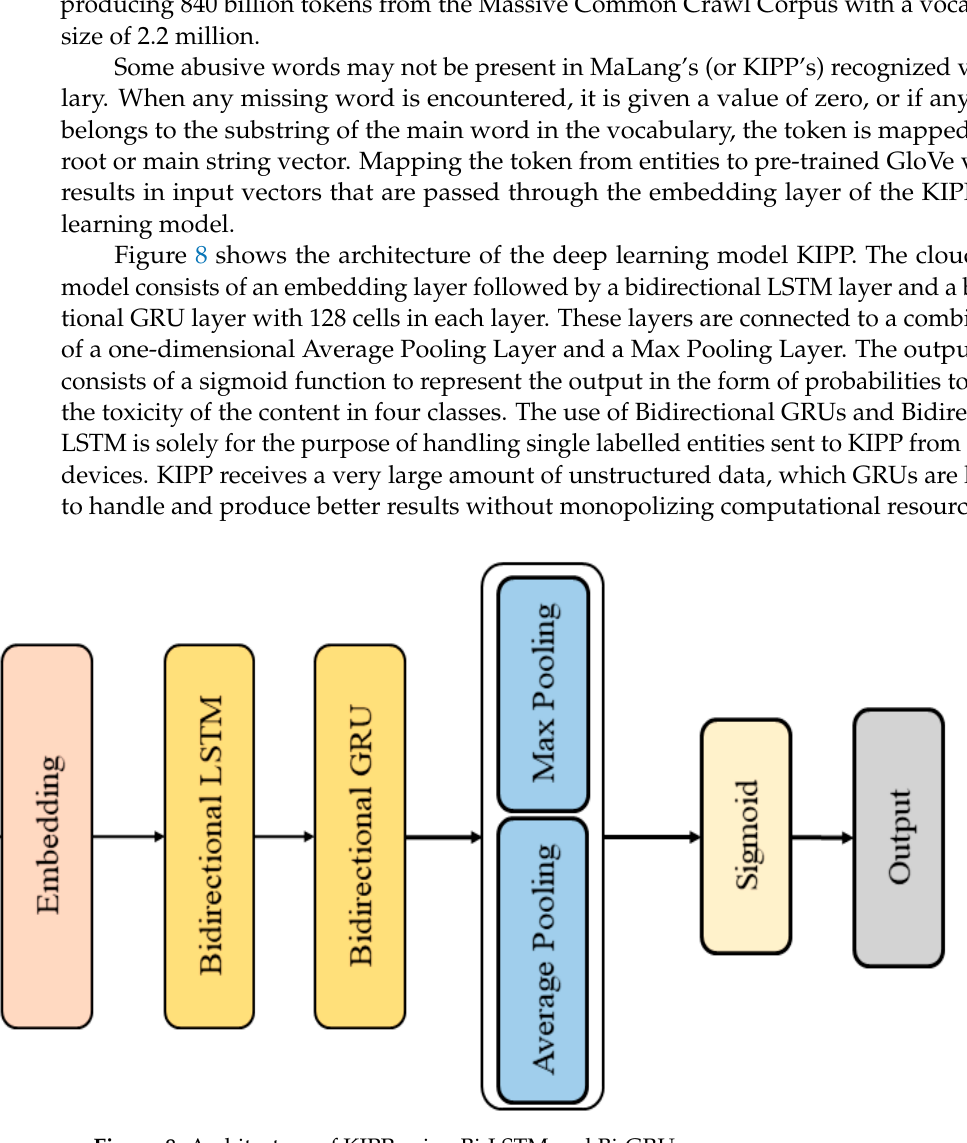
Figure 8. Architecture of KIPP using Bi-LSTM and Bi-GRU.